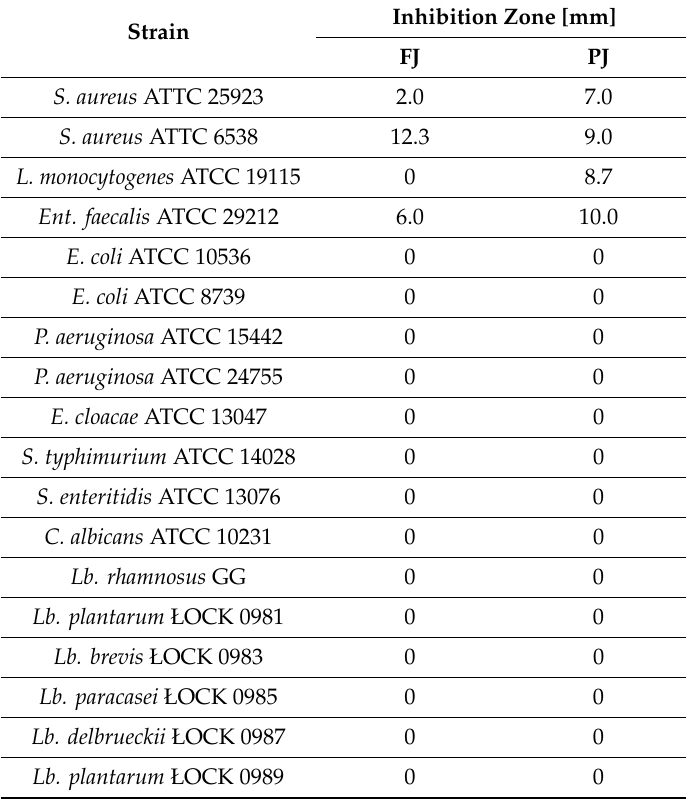
Table 2. The antimicrobial activity of V. opulus FJ and